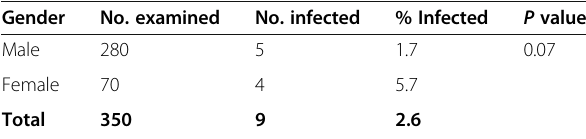
Table 2 Overall prevalence of HIV infection in relation to gender among the inmates in Umuahia Prison, Abia